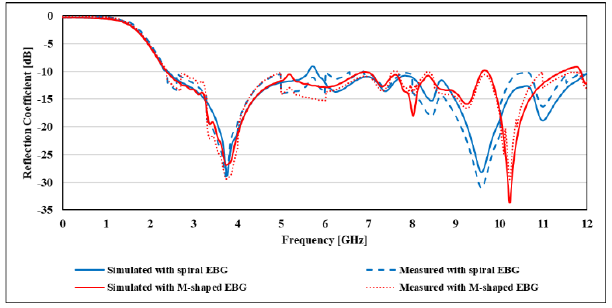
Figure 17. Variation in S-parameter v/s frequency for spiral and M-shaped EBG near feed. SAR values for 1 gram tissue mass aimed at UWB-CMSA, UWB-CMSA with spiral EBG unit cells, and UWB-CMSA with M-shaped EBG unit cells are compared in Table I. TABLE I. Comparison of SAR [W/Kg] in 1 gram tissue mass Frequency